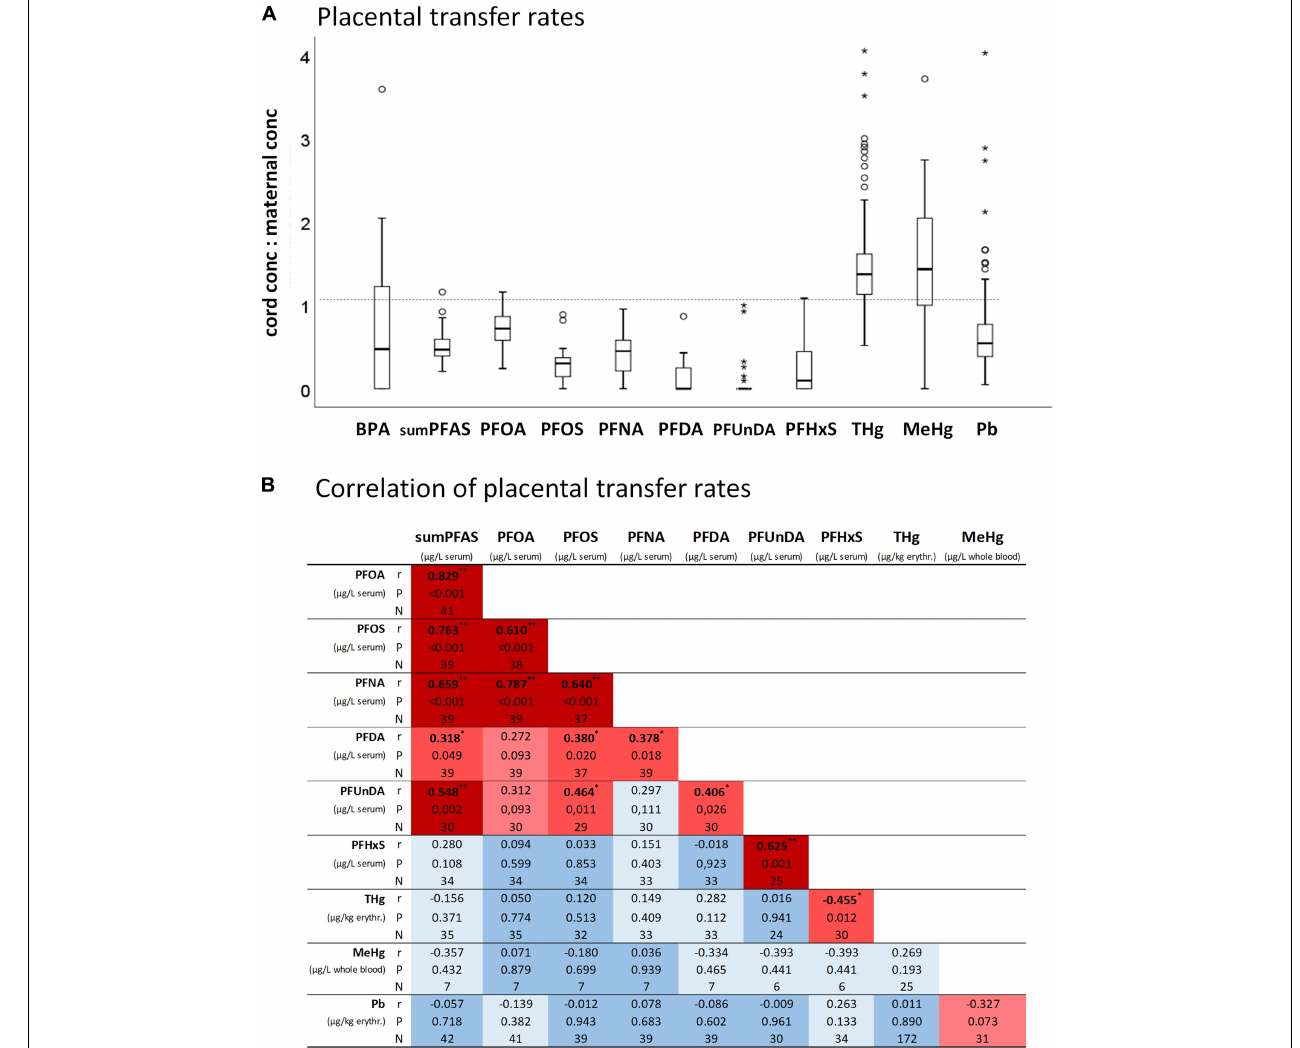
FIGURE 3 | (A) Placental transfer rates (i.e., umbilical cord blood concentrations to maternal blood concentrations) of BPA ( N = 14), sumPFAS ( N = 42), PFOA ( N = 41), PFOS ( N = 39), PFNA ( N = 39), PFDA ( N = 39), PFUnDA ( N = 30), PFHxS ( N = 34), THg ( N = 172), MeHg ( N = 32), Pb ( N = 198). (B) Correlation heatmap of placental transfer rates. * P < 0.05 and ** P < 0.01 from Spearman correlation